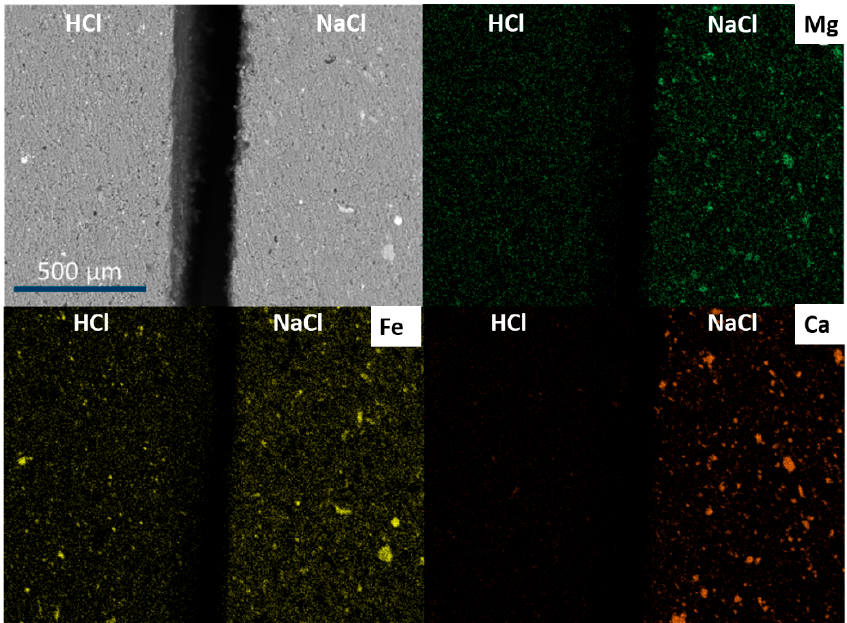
Figure 6. SEM BSE image and EDX maps showing distribution of calcium, magnesium and iron elements on surfaces of cross-sections of shale samples exposed to 1 M HCl ( left ) and 1 M NaCl ( right ) after 96 h of exposure.